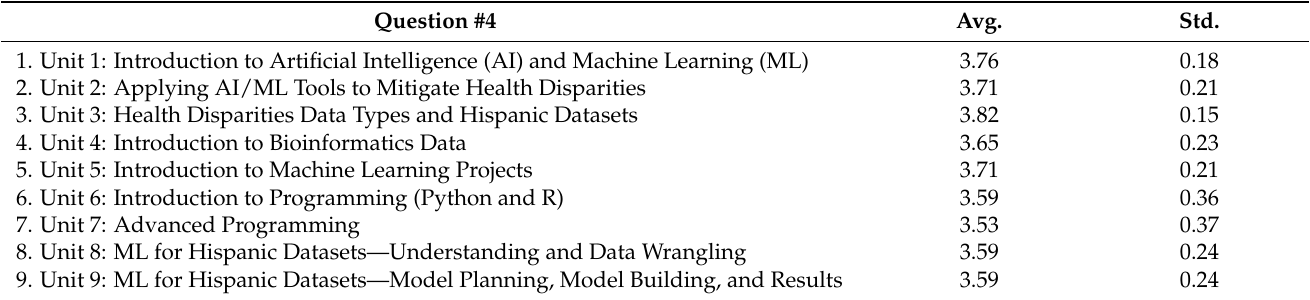
Table 3. Evaluation for course topics (Question #4) using the average (Avg.) and standard deviation (Std.) of the ordinal ‐ scale values.